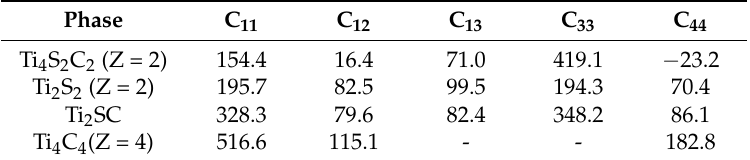
Table 2. Elastic constants of C ij (GPa) of